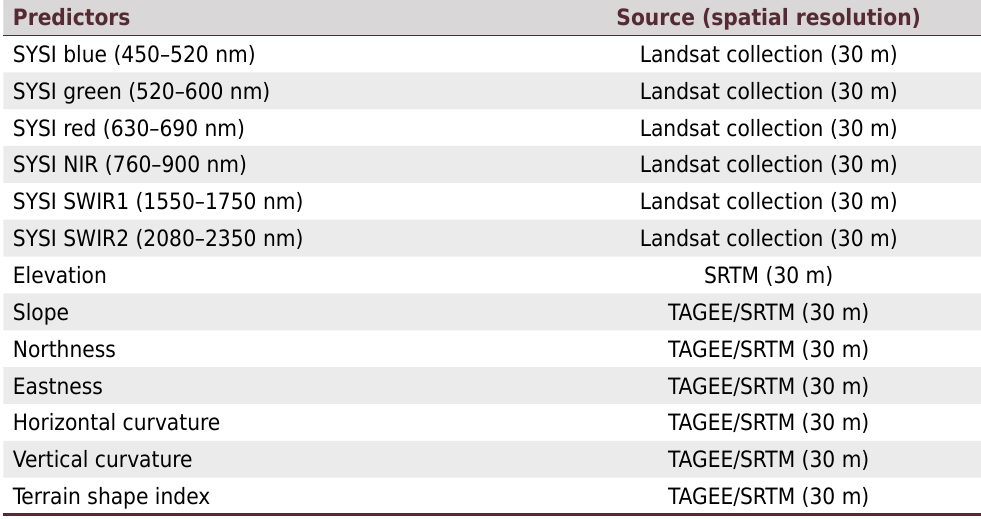
Table 1. Predictors used for model